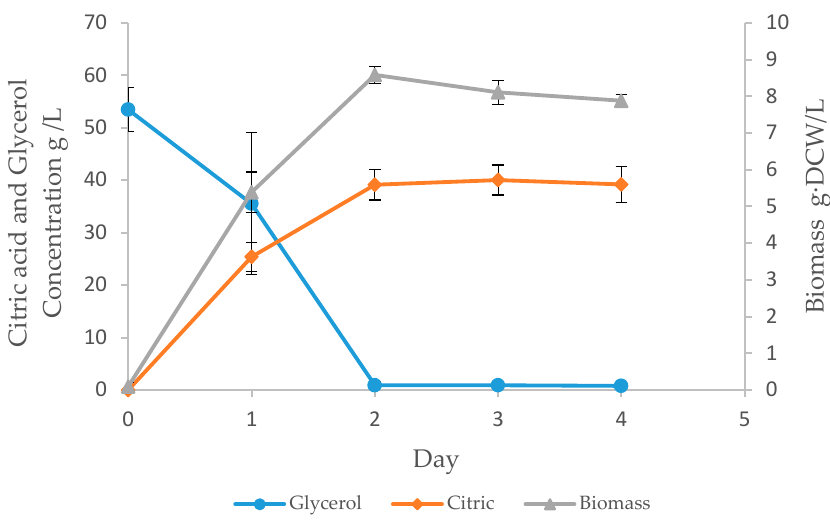
Figure 4. Time course study of glycerol utilization, biomass proliferation, and citric acid production by the ML strain/treatment. Glycerol based YNB-Ura media under nitrogen-limiting conditions (C/N = 50). Data from 2 rounds of batch fermentation. ML: Δ POX1-6 Δ LEU2 Δ SNF1 Δ FAA1 + Δ LEU2:: YlALK5 YlCPR YlFAO1 + YlALK5:: URA3 + 400 mg/L leucine.